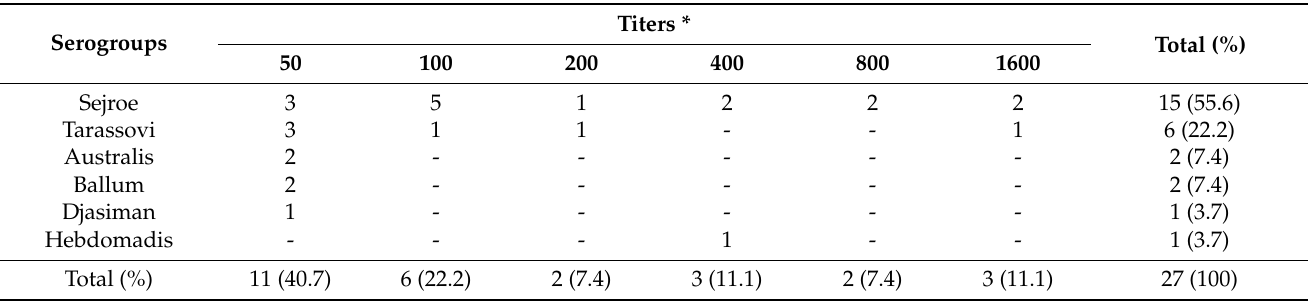
Table 1. Predominant serogroups and respective antibody titers at MAT in cattle from the Caatinga biome, Brazil.